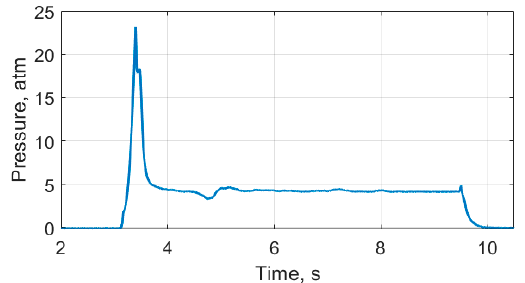
Figure 11. Pressure plot for the similar SRM.